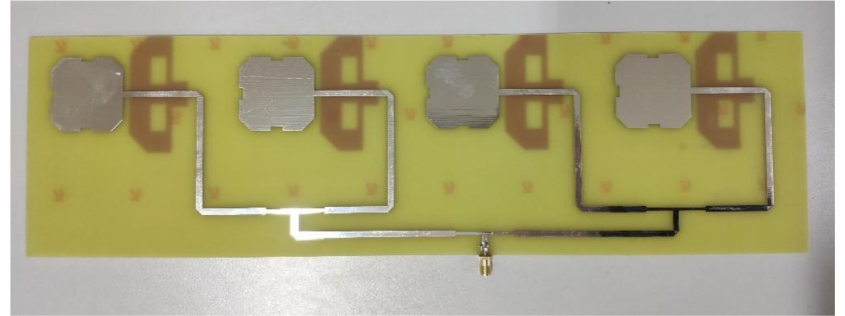
Figure 16. Receiving antenna in